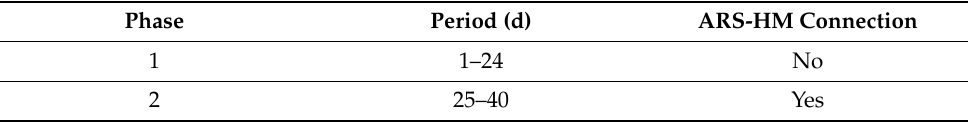
Table 1. Different phases and operation conditions of the